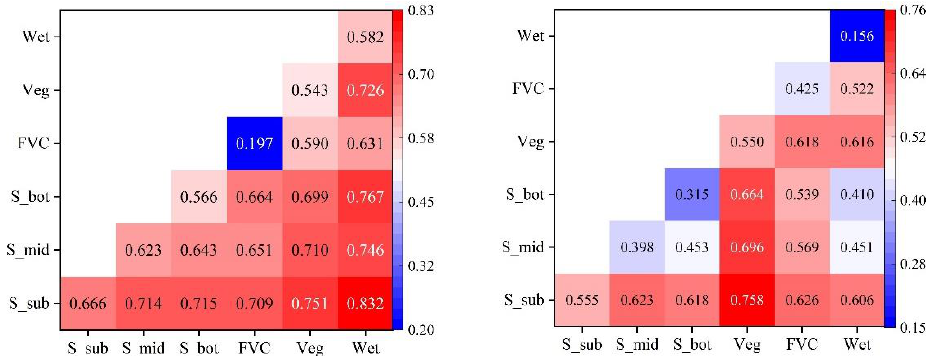
Figure 6. Interactive detection results in different seasons. S_sub, S_mid, S_bot, Wet, FVC, Veg represent subsurface soil salinity, middle soil salinity, bottom soil salinity, soil water content, vegetation coverage, and vegetation cover type, respectively.